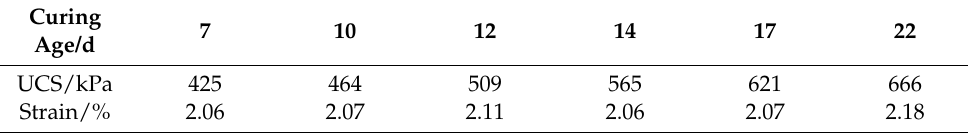
Table 5. UCS and strain of OCC at failure point.